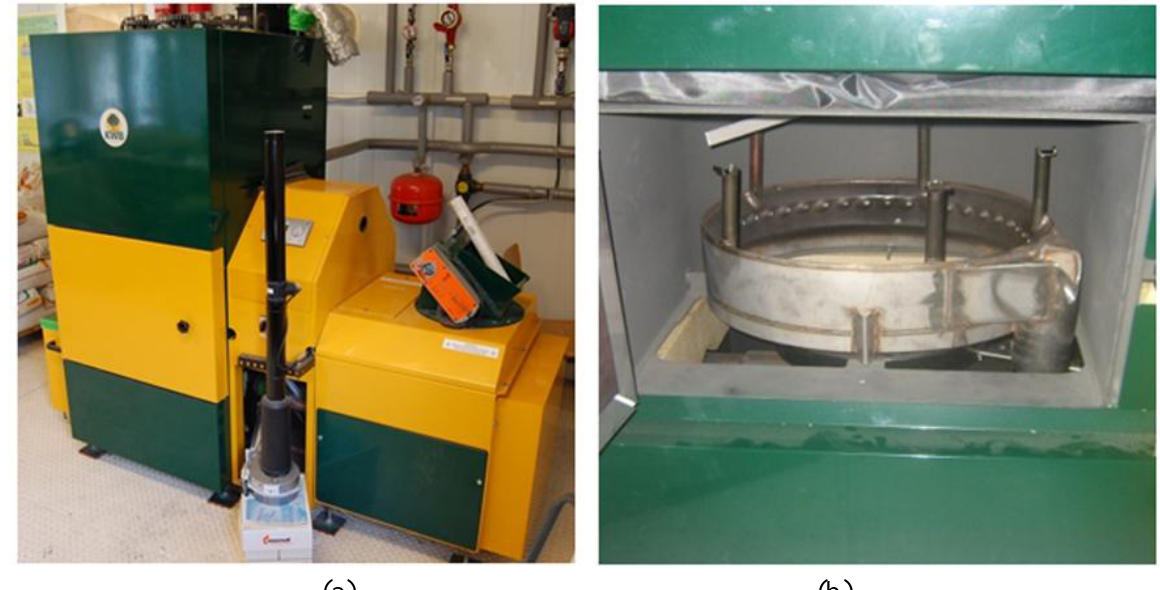
Figure 1. (a) General view of the boiler (b) Detail of the combustion